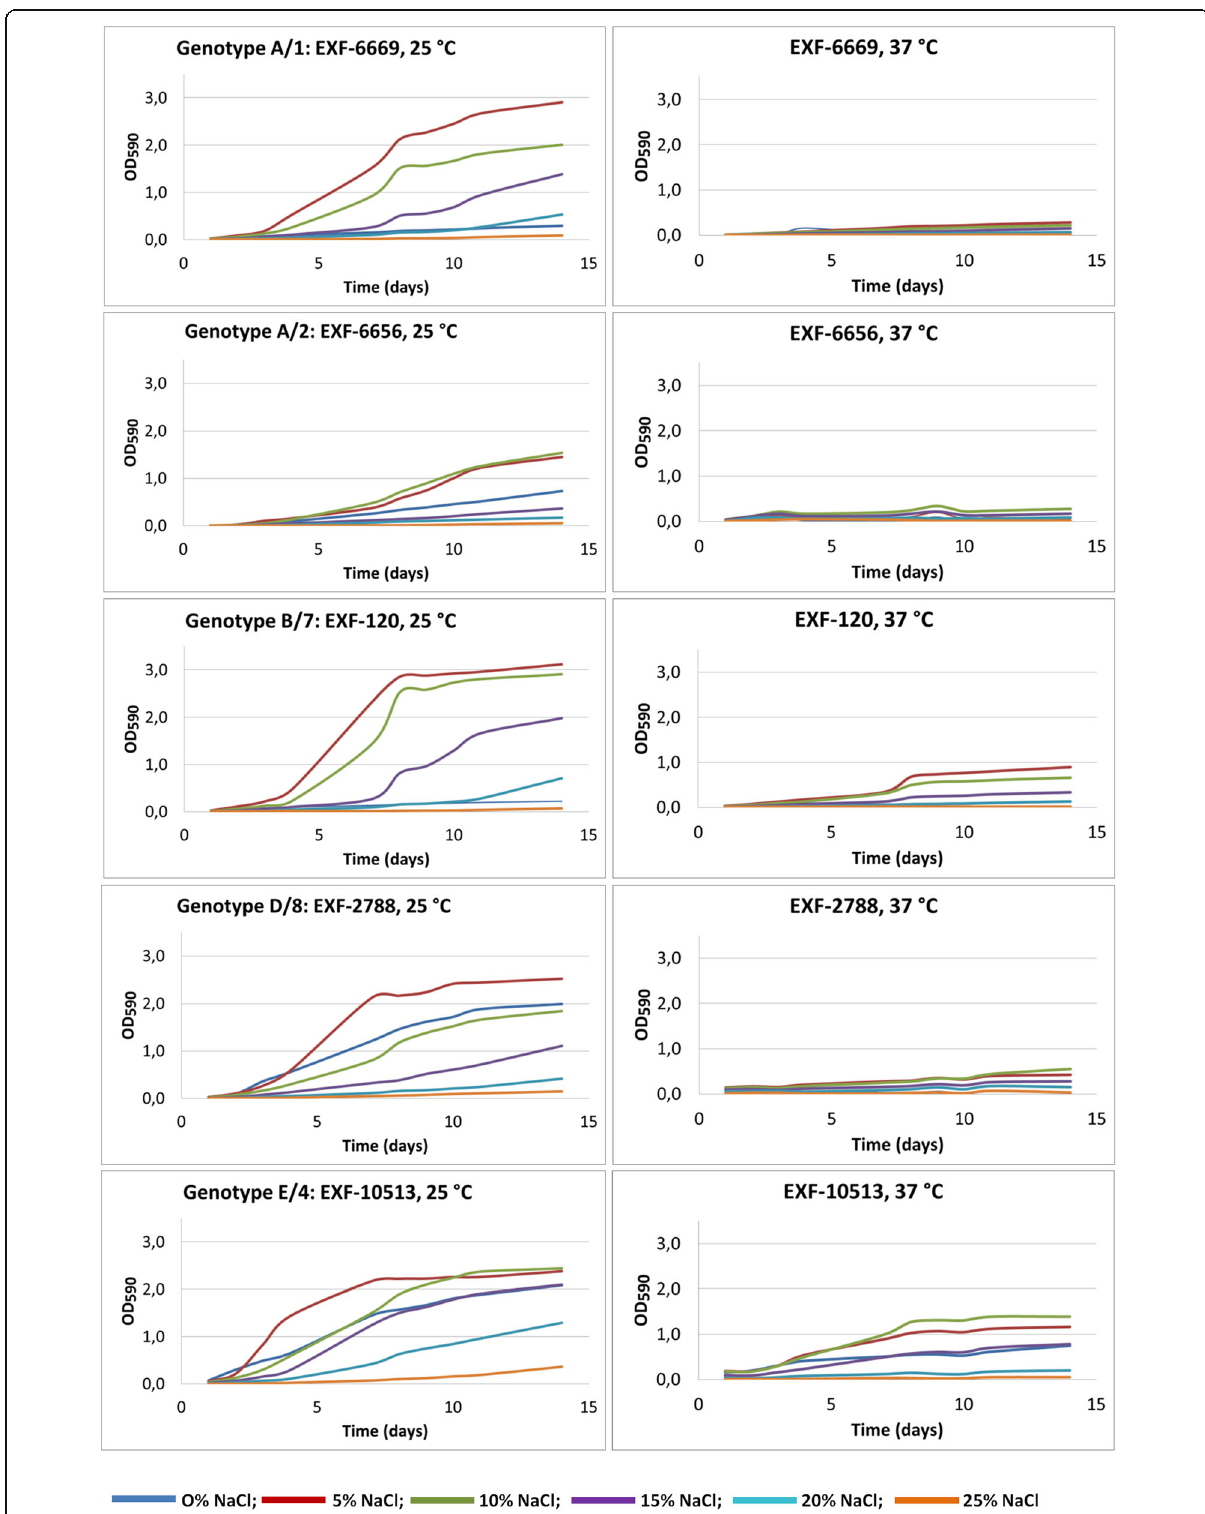
Fig. 8 Growth curves of selected Hortaea werneckii strains grown in YNB liquid media without and with added 5, 10, 15, 20, and 25% NaCl, incubated at 25 °C and 37